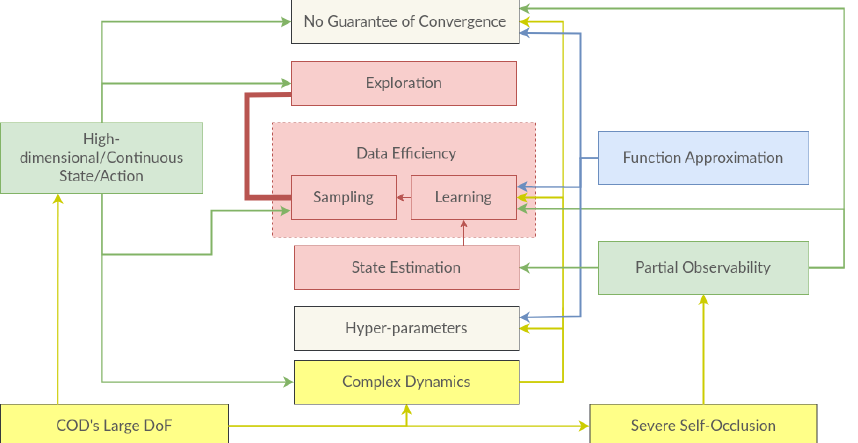
Figure 3. The key challenges of data-driven control in CDO: (in yellow) challenges caused by the nature of CDO, (in green) challenges caused by use of POMDP, (in blue) challenges caused by using neural networks and (in red) key